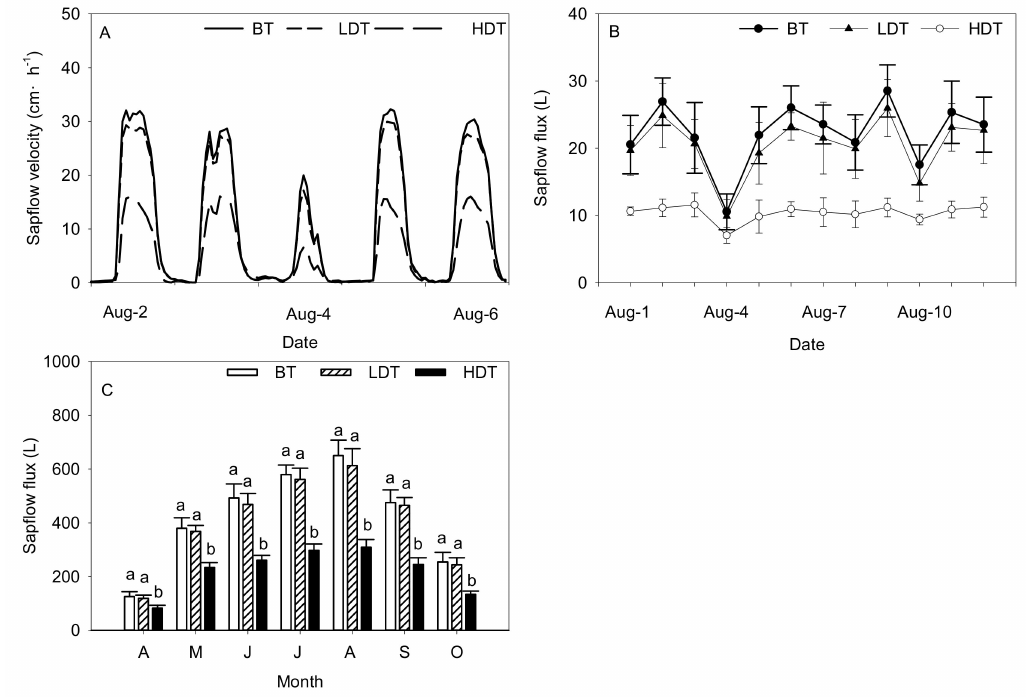
Figure 7. Sap flow velocity ( A ) and sap flow flux ( B ) among the three density groups of Mongolian pine trees. Sap flow flux among the BT, LDT, and HDT groups at a monthly timescale ( C ). Lower-case letters indicate significant di ff erences at p < 0.05.